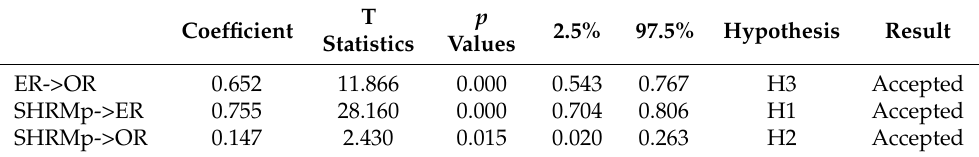
Table 6. Results of the direct hypothesis.